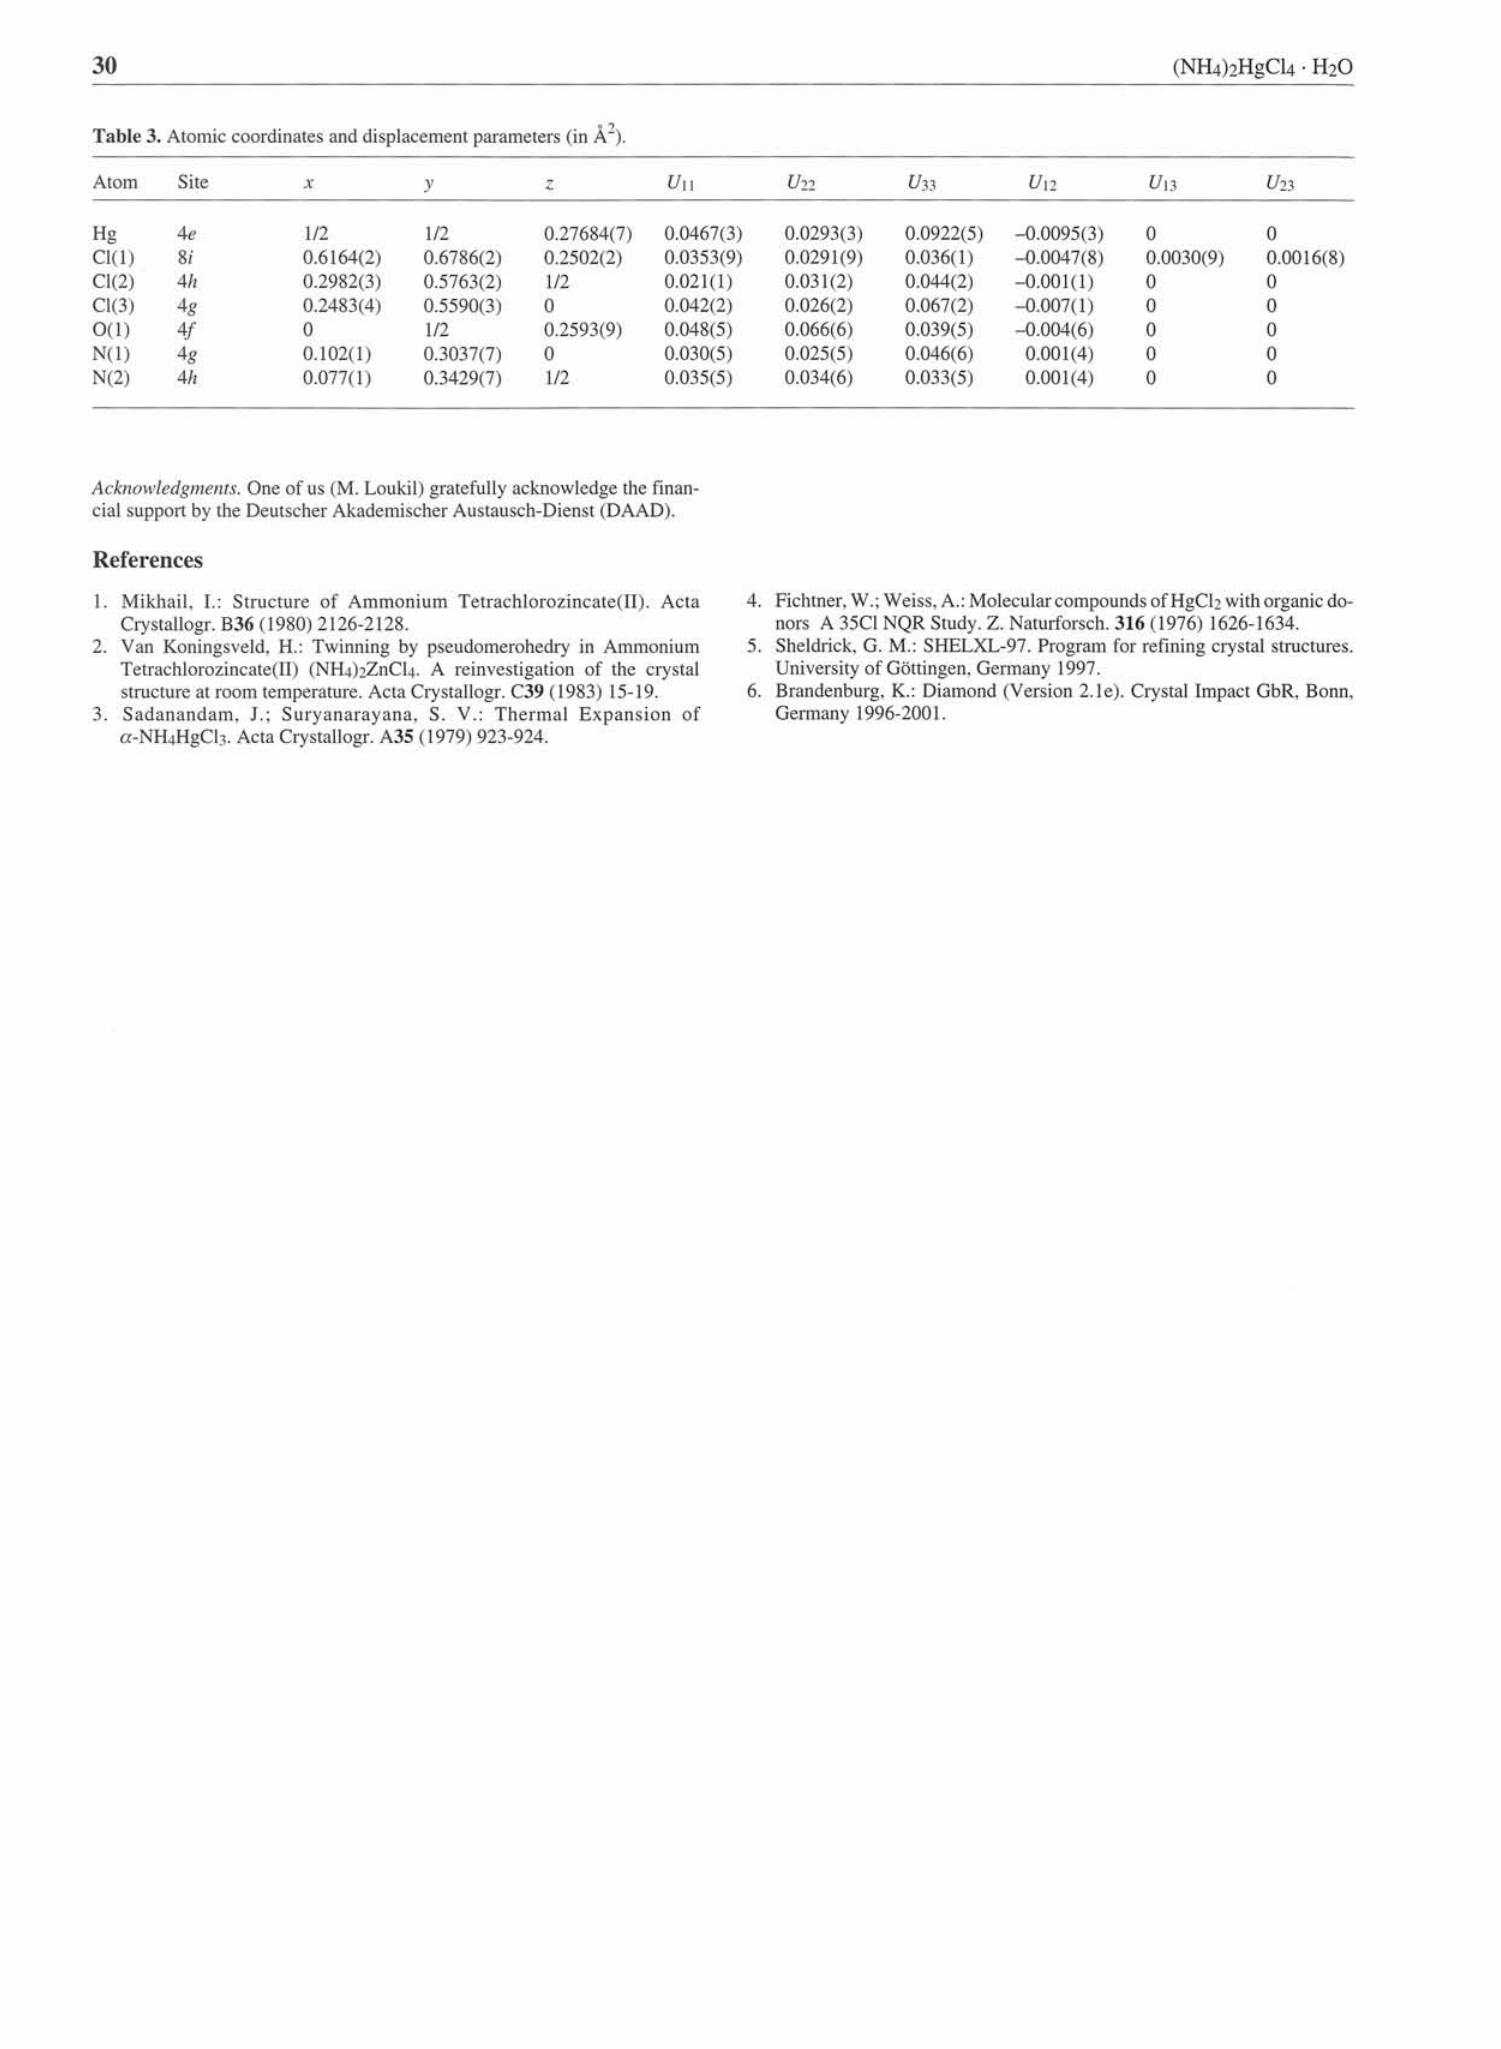
Table 3. Atomic coordinates and displacement parameters (in Ä :